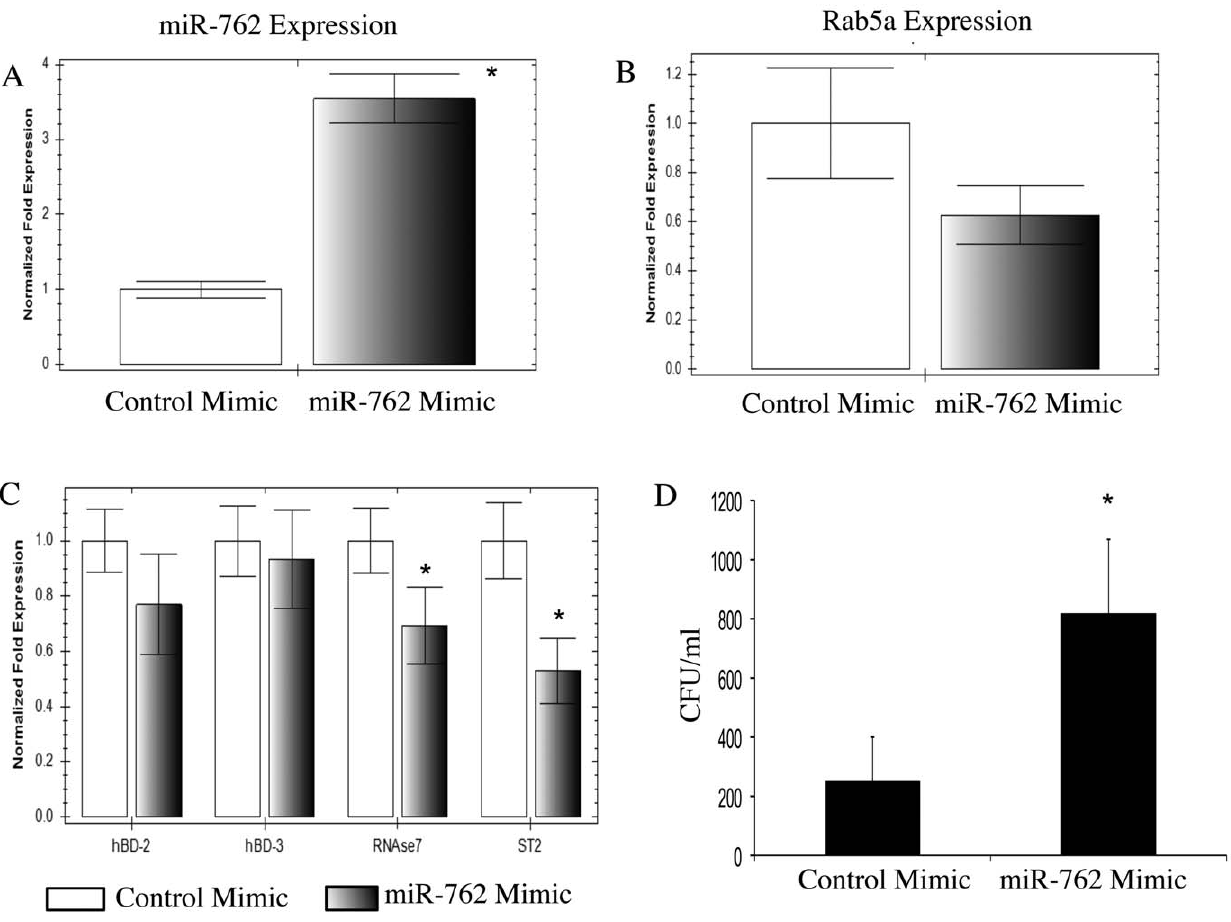
Figure 3. The effect of a miR-762 mimic on gene expression in human corneal epithelial cells and on P.aeruginosa invasion. a Transfection of human corneal epithelial cells with a mimic of miR-762 increased the expression of miR-762 relative to a control (scrambled) mimic, b decreased Rab5a mRNA expression (although that difference was not significant), c significantly decreased mRNA expression of RNase7 and ST-2, but not that of hBD-2 or hBD-3, and d increased P. aeruginosa invasion (* p = 0.044, t-Test). Gene expression was measured by real-time PCR, and P. aeruginosa invasion using gentamicin exclusion assays. In each experiment, cells were used at 48 h after transfection. At 72 h, epithelia were challenged with 10 4 cfu P. aeruginosa strain 6294 for 3 h followed by 1 h gentamicin treatment (see Methods). (* Significant difference vs. respective controls, t-Test). , 50% relative to a scrambled control (Fig. 2 a, p , 0.05, t-Test). increased RNase7 and ST-2 mRNA levels. Therefore, we over- expressed miR-762 by transfection with a miR-762 mimic, and Accordingly, Antago-762 increased expression of Rab5a mRNA, a compared mRNA levels of target genes and bacterial internaliza- predicted target of miR-762 (based upon analysis of predicted tion compared to a scrambled control. Real-time PCR confirmed targets for miR-762 using microRNA.org), by , 75% relative to successful transfection of miR-762 after 48 h (Fig. 3 a). Over- the scrambled control (Fig 2 b, p , 0.05, t-Test). Interestingly, expression of miR-762 suppressed Rab5a mRNA expression by Antago-762 also increased gene expression of RNase7 (by , 80%) , 35% although this was not statistically significant (Fig. 3 b, p . and ST-2 (by , 58%) (Fig. 2 c, p , 0.05, t-Test for each), 0.05, t-Test). However, miR-762 suppression of RNase7 (by suggesting that miR-762 negatively regulates the expression of , 30%) and ST-2 (by , 47%) mRNA expression was significant genes encoding these innate defense factors. Antago-762 did not (Fig. 3 c, p , 0.05, t-Test, for each versus respective controls). The affect the expression of genes encoding hBD-2 and hBD-3 (Fig. 2 miR-762 mimic did not significantly affect mRNA levels of hBD-2 c), two other antimicrobial peptides expressed by these epithelia or hBD-3 (Fig. 3 c). The miR-762 mimic increased susceptibility to [32,33], nor did it affect bacterial internalization by these epithelial bacterial internalization by , 3.5-fold (Fig. 3 d, p , 0.05, t-Test). cells (Fig. 2 d). Tear fluid induction of miR-762 negatively regulates RNase7 and ST2 Having shown tear-antigen upregulation of miR-762, and miR- 762 negative regulation of genes encoding RNase7 and ST2 without tears, we next used a miR-762 antagomir to test the relationship between tear exposure, miR-762 induction, and